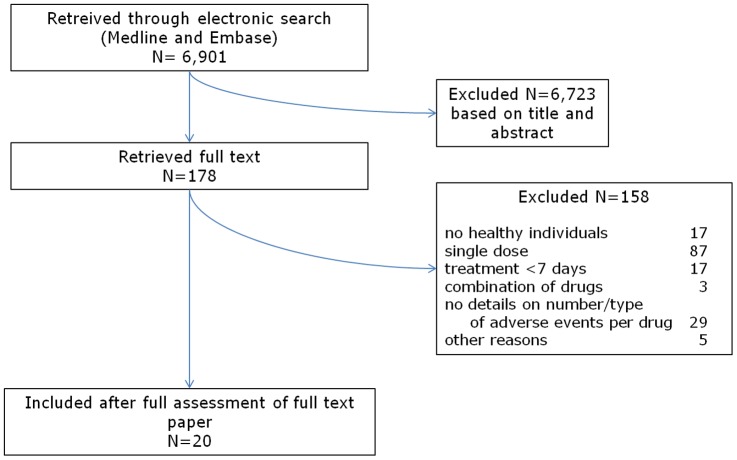
Systematic review process flowchart.